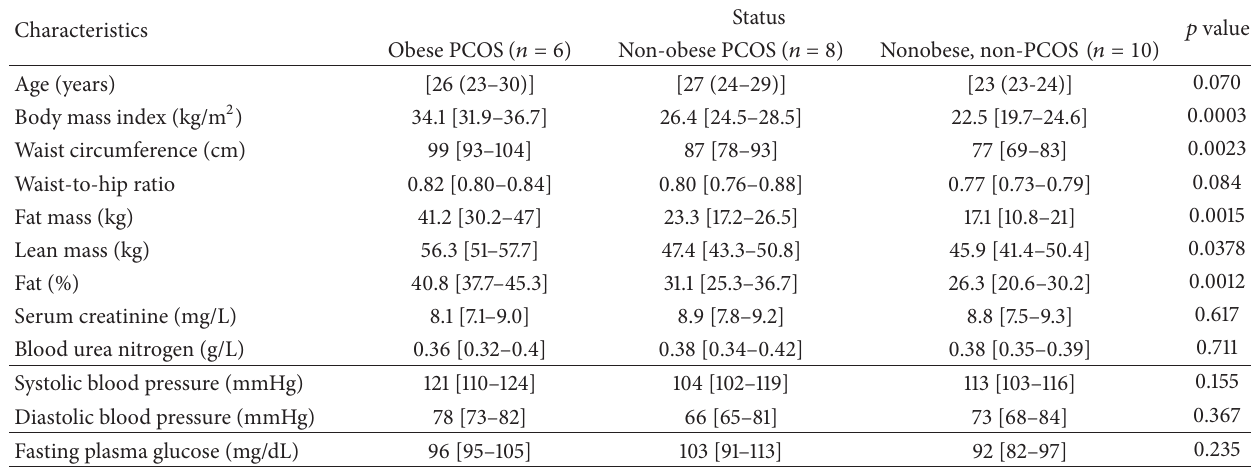
Table 1: Clinical and biological characteristics of the study population.